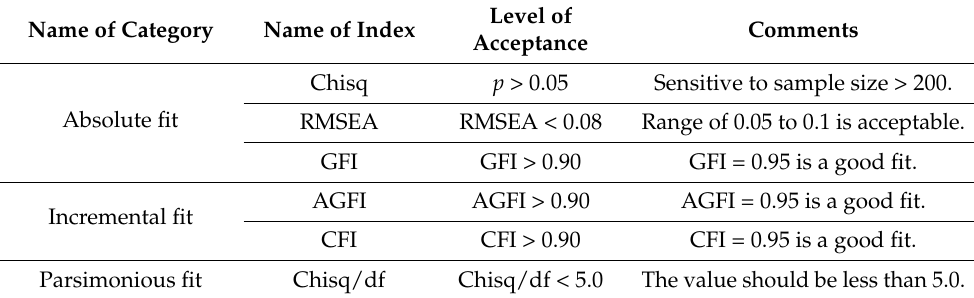
Table 1. Model Fit Categories and Indexes.